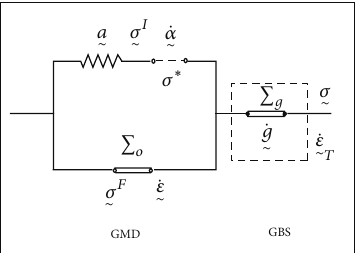
Figure 2: A topological model for SSP